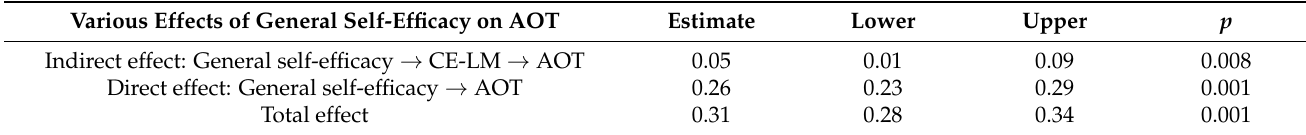
Table 4. Direct, indirect, and total effect of general self-efficacy on